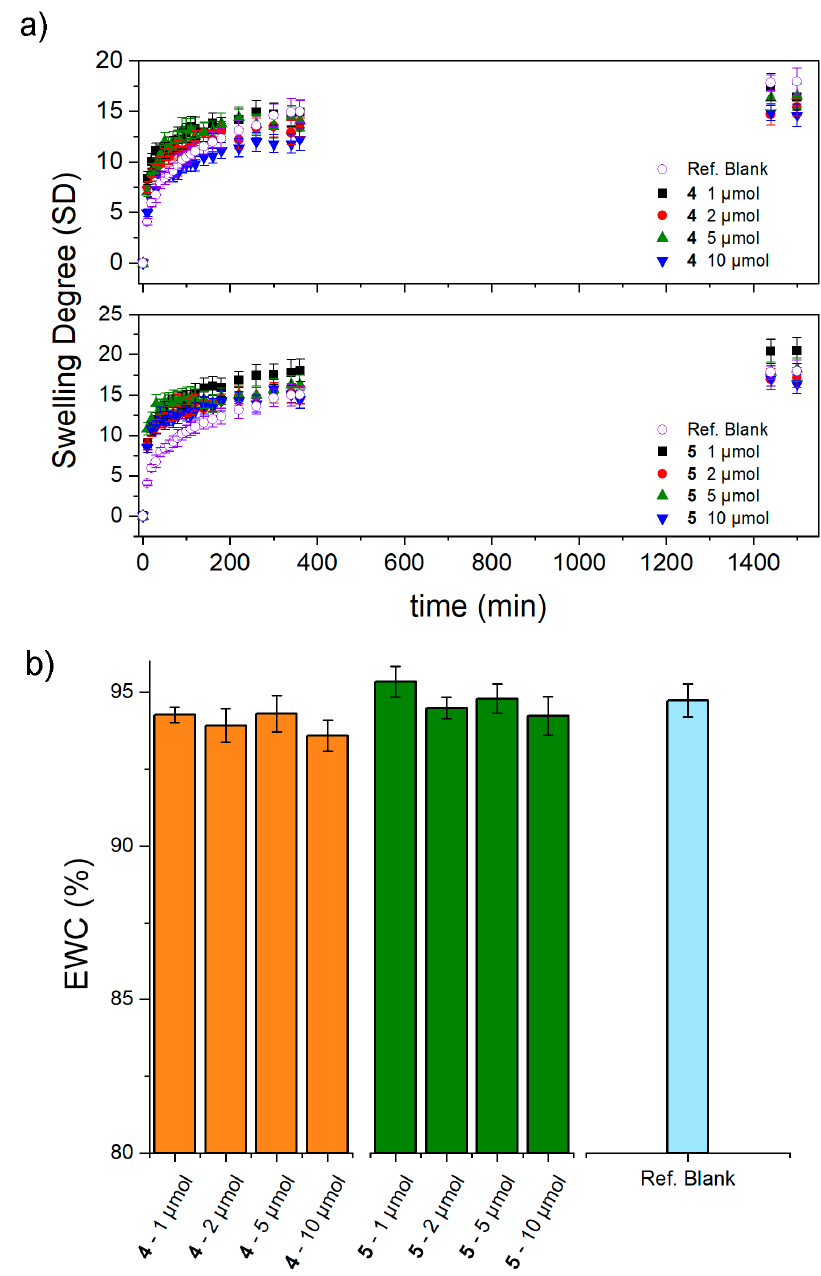
Figure 3. ( a ) Swelling behavior of gelatins treated with 4 and 5 at different concentrations in distilled H 2 O, compared to untreated gelatin (blank); ( b ) water content of hydrogels at